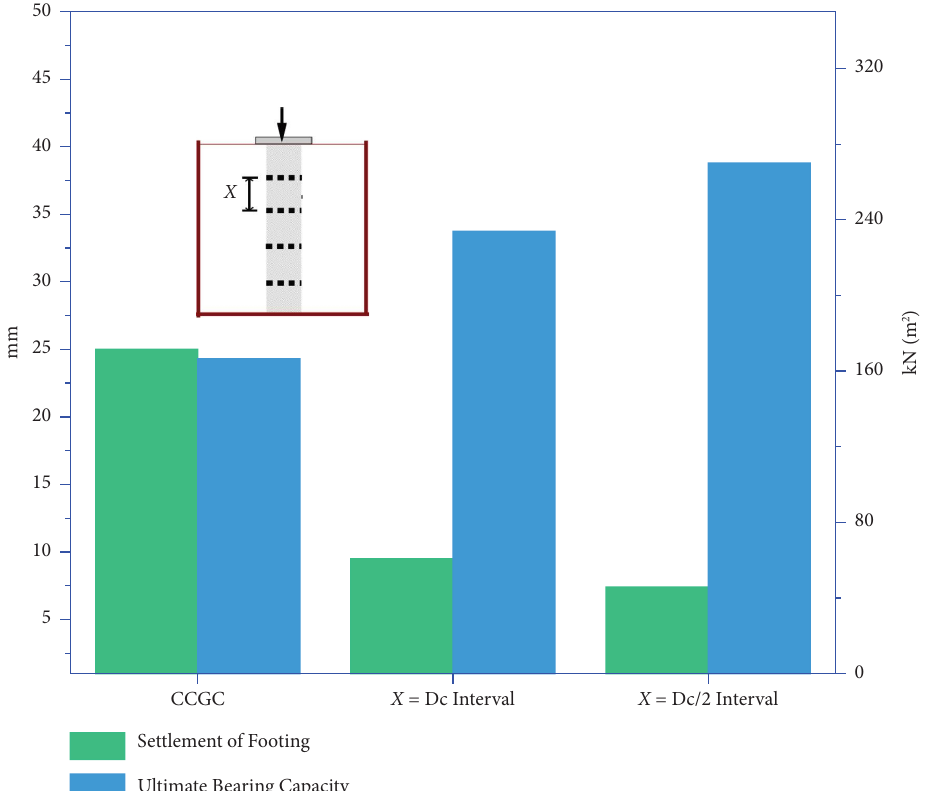
Figure 17: Efect of spacing ( x ) of horizontal reinforcement on the ultimate bearing capacity-settlement relationship for improved soft